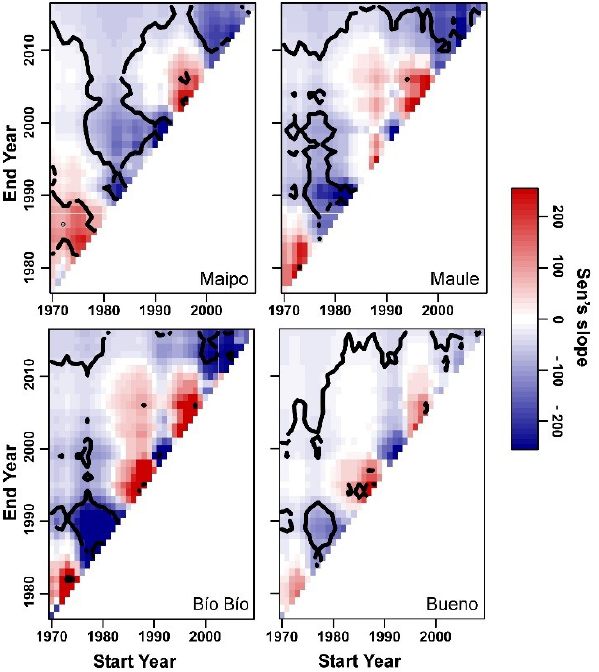
Figure 8. Multi-temporal trend diagrams for hydropower potential between 1970 and 2016 in the four study basins. Trends in MW are presented in red (positive), white (null) and blue (negative). Contour lines indicate the statistical significance at the 95% confidence level ( p = 0.05).